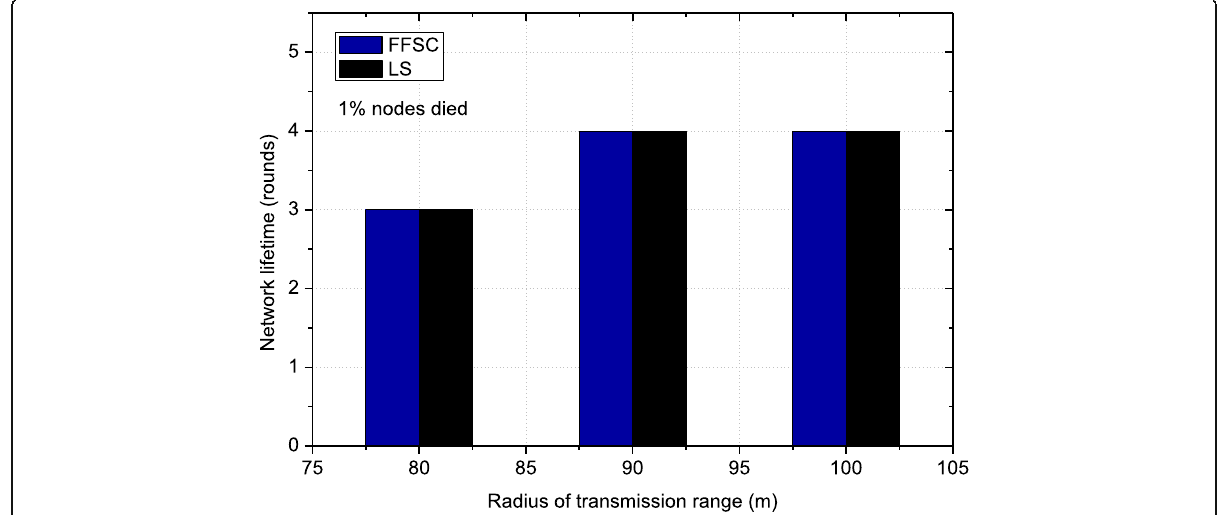
Fig. 17 The network lifetime under different transmission